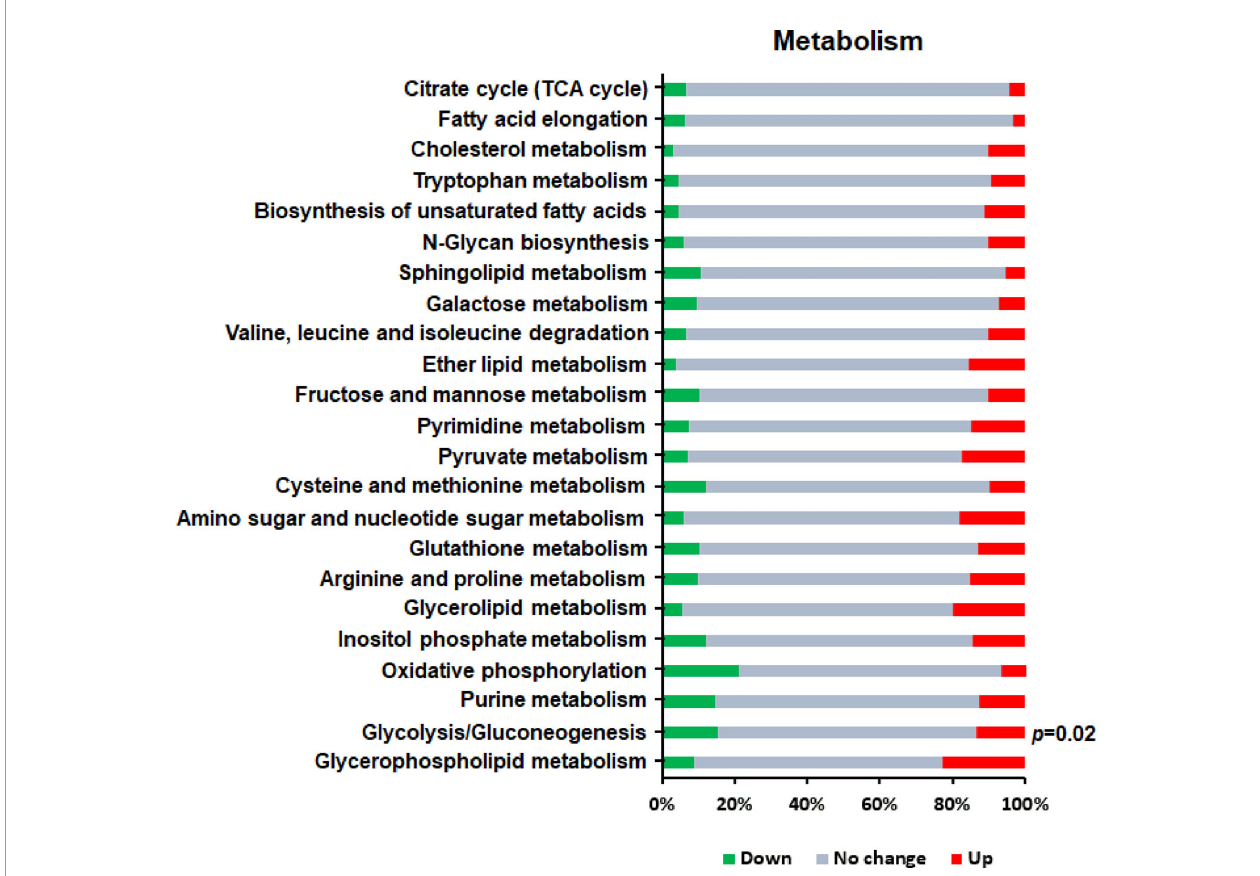
FIGURE 6 | KEGG enrichment analysis of DEGs in metabolism related to Th1 cell differentiation. Red bars represent up-regulated genes, green bars represent down-regulated genes, and gray bars represent unchanged